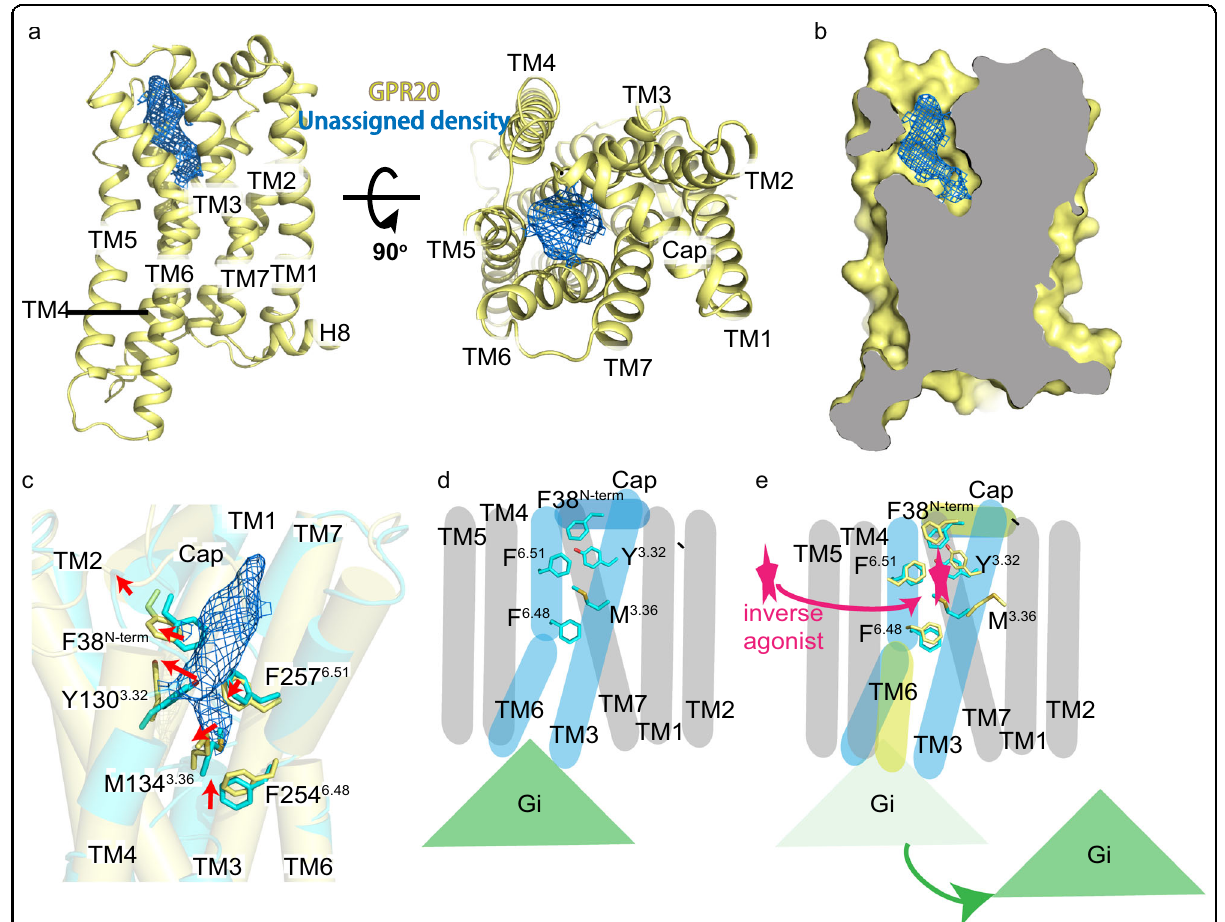
Fig. 6 Unassigned density in the orthosteric pocket. a Two orthogonal views of the cartoon representation of GPR20 in yellow. The unassigned electron density observed in the canonical orthosteric pocket of GPR20 in the Gi-free GPR20-Fab046 complex is shown as a blue mesh. b A cross- section view of GPR20 in the GPR20-Fab046 structure (yellow) to show the shape complementarity of the unassigned electron density (blue mesh) with the orthosteric pocket. c Overlay between GPR20-Fab046 (yellow, unassigned density shown as a blue mesh) and GPR20-Gi-Fab046 (cyan) structures. Key residues of the hydrophobic network are shown as sticks. d , e Working model of putative activation mechanism for